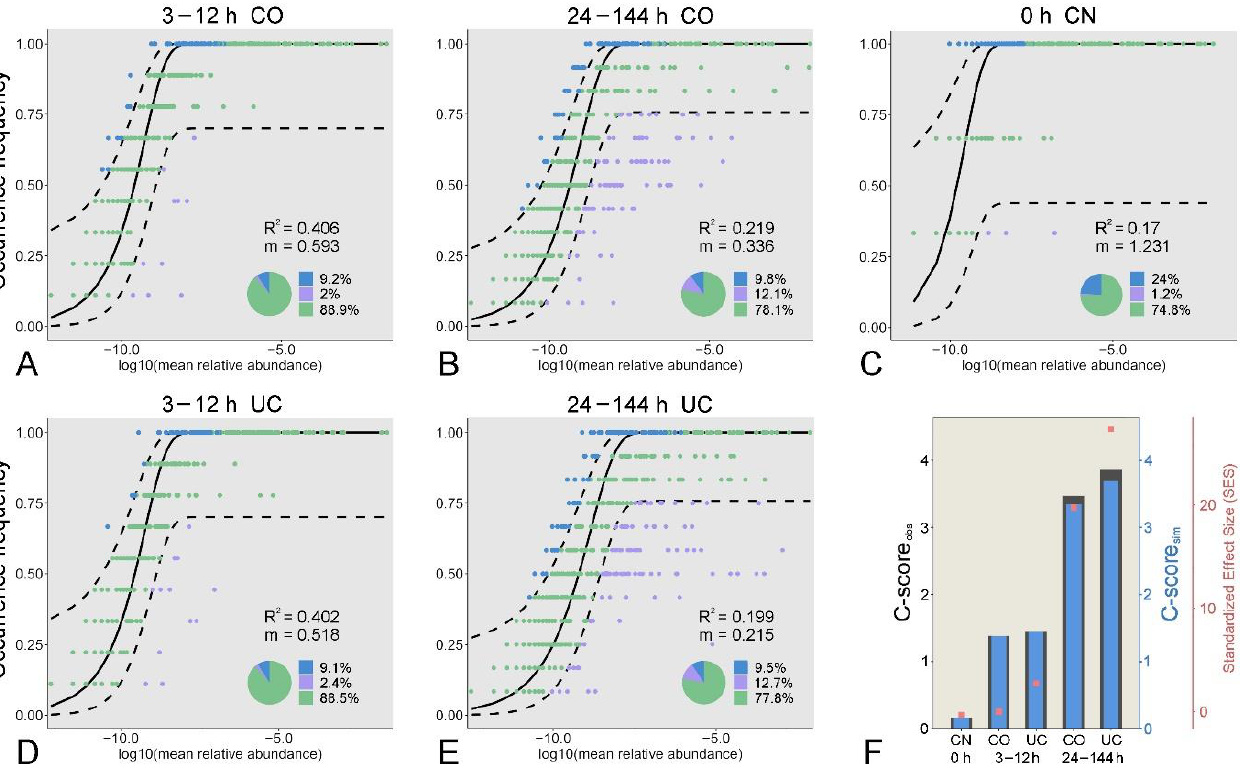
Figure 6. Fit of the occurrence frequency of eukaryotic OTUs as a function of mean relative abundances based on the neutral community model for the microbial communities under different storage conditions ( A – E ). The solid black line indicates the best fit to the model, and the dashed black line represents 95% confidence intervals around the model prediction. OTUs that occur within prediction are shown in green, and OTUs that occur more or less frequently than predicted are shown in blue and purple, respectively. R 2 indicates the fit to the model, and m indicates the immigration rate. C-score metric based on null models ( F ). The values of observed C-score (C-score obs ) > simulated C-score (C-score sim ) indicate non-random co-occurrence patterns. Standardized effect size (SES) > 2 and < − 2 represent significant segregation and aggregation, respectively. CN: control group, CO: with lid closed, UC: without